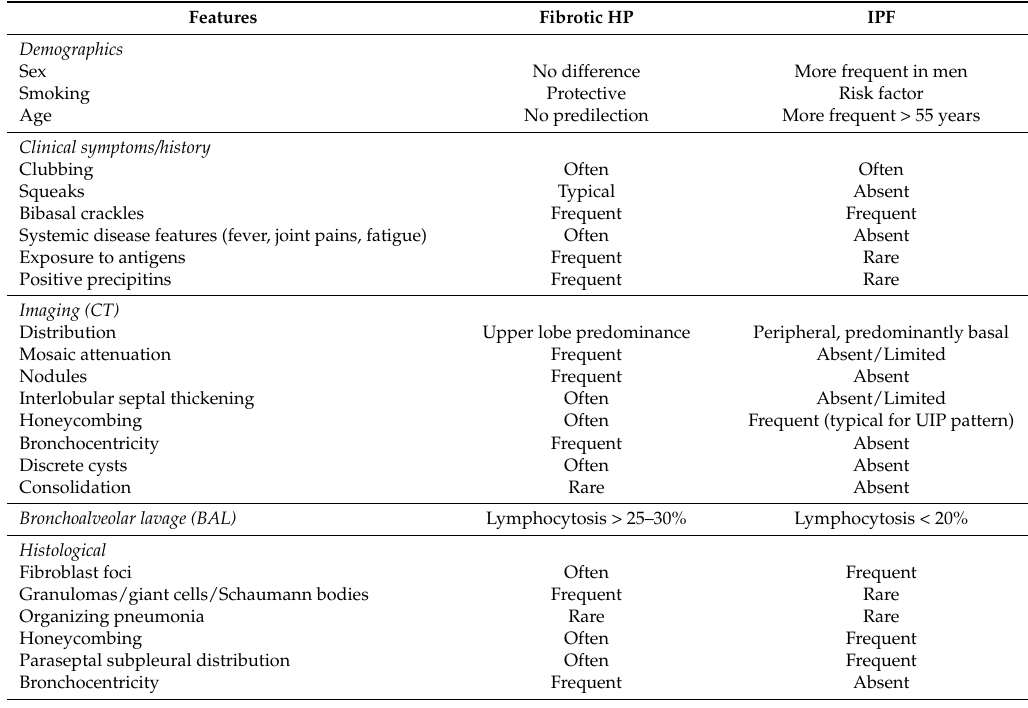
Table 1. Similarities and differences in clinical, radiological and histopathological features between fibrotic HP and idiopathic pulmonary fibrosis